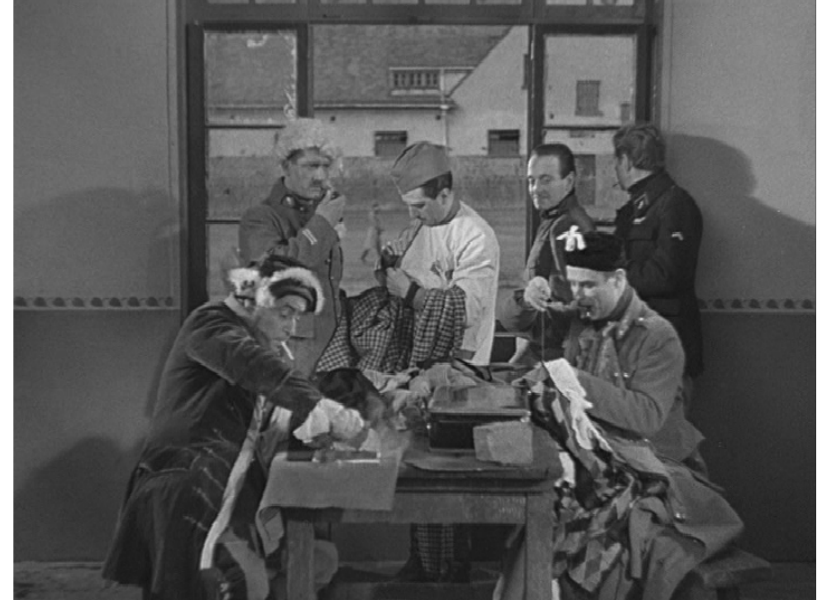
Figure 2 Le Grande Illusion . Director: Jean